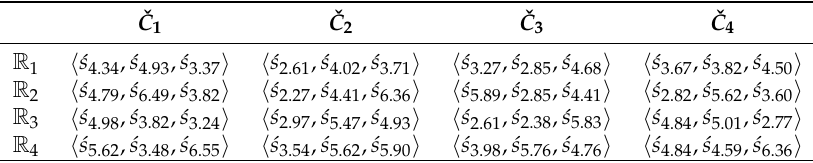
Table 5. Aggregated value of R by utilizing the LSFOWG operator.